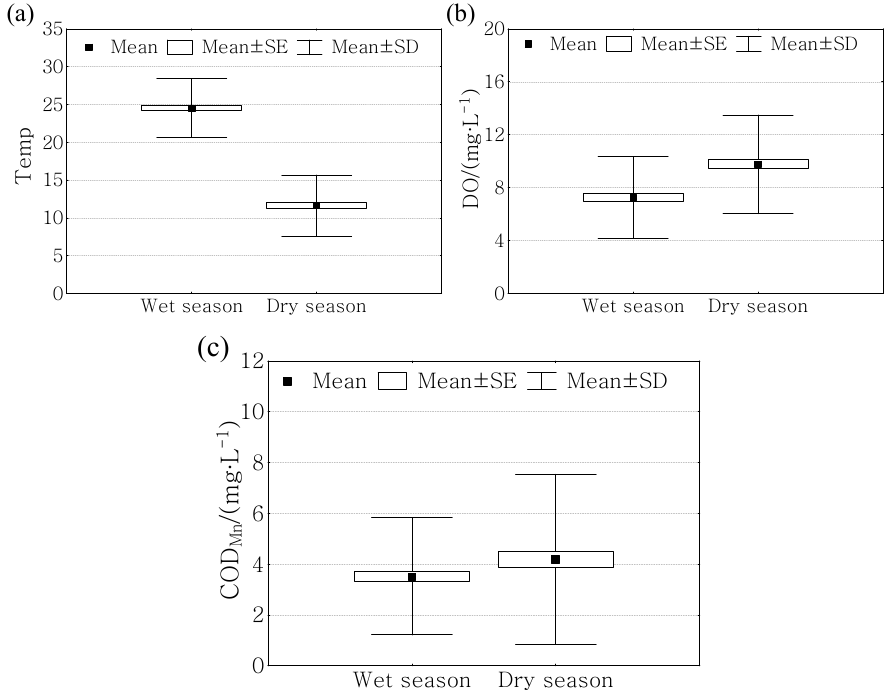
Figure 4. Temporal variations: ( a ) Temp; ( b ) DO, and ( c ) COD Mn in Danjiangkou Reservoir Basin.